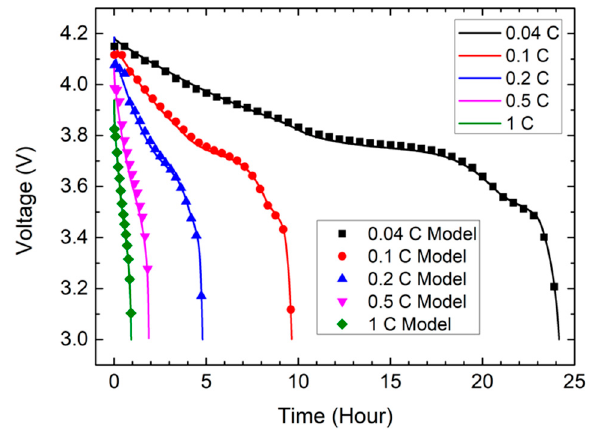
Figure 10. Curve of S brand 18650, Epoch = 100, look_back = 10.